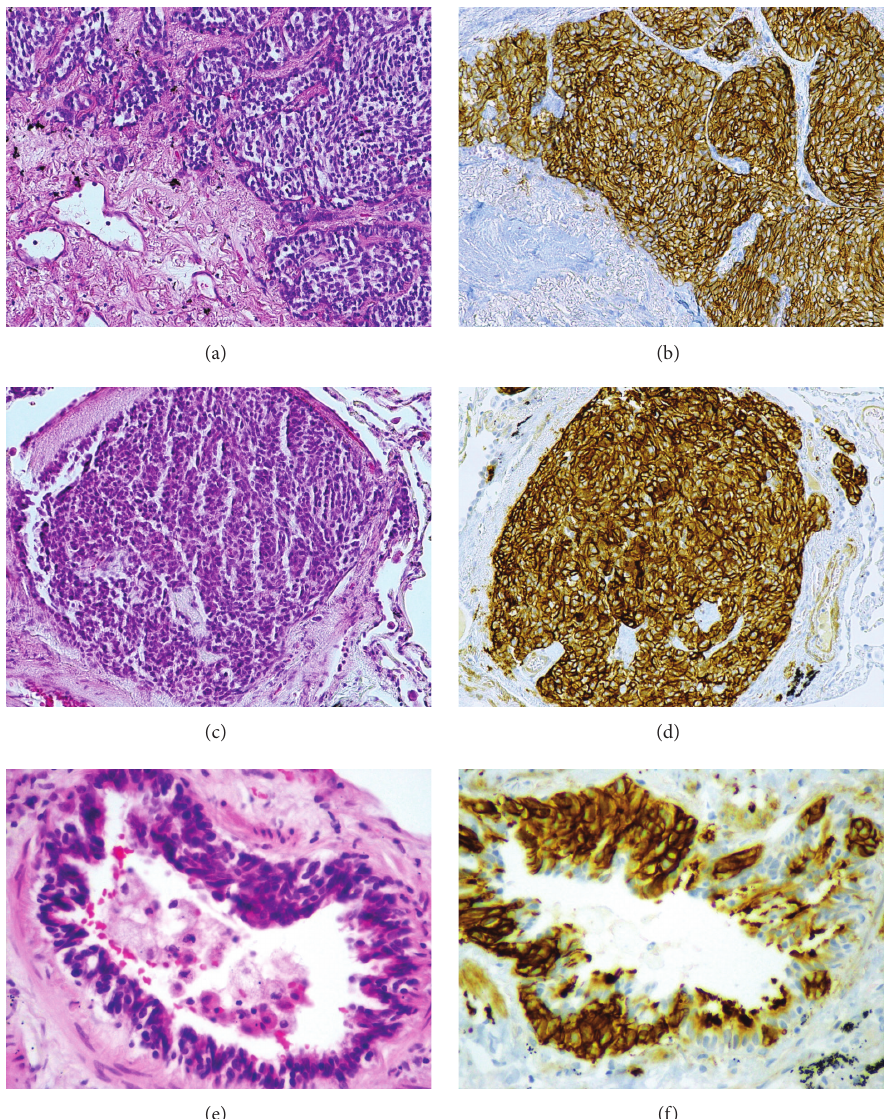
Figure 3: Case 3. (a) Carcinoid tumor; in the left lower corner central hyalinization can be seen. (b) Carcinoid with strong and diffuse expression of CD56. (c) Tumorlet. (d) Tumorlet also showing strong and diffuse expression of CD56. (e) DIPNECH. (f) Strong expression of CD56 in